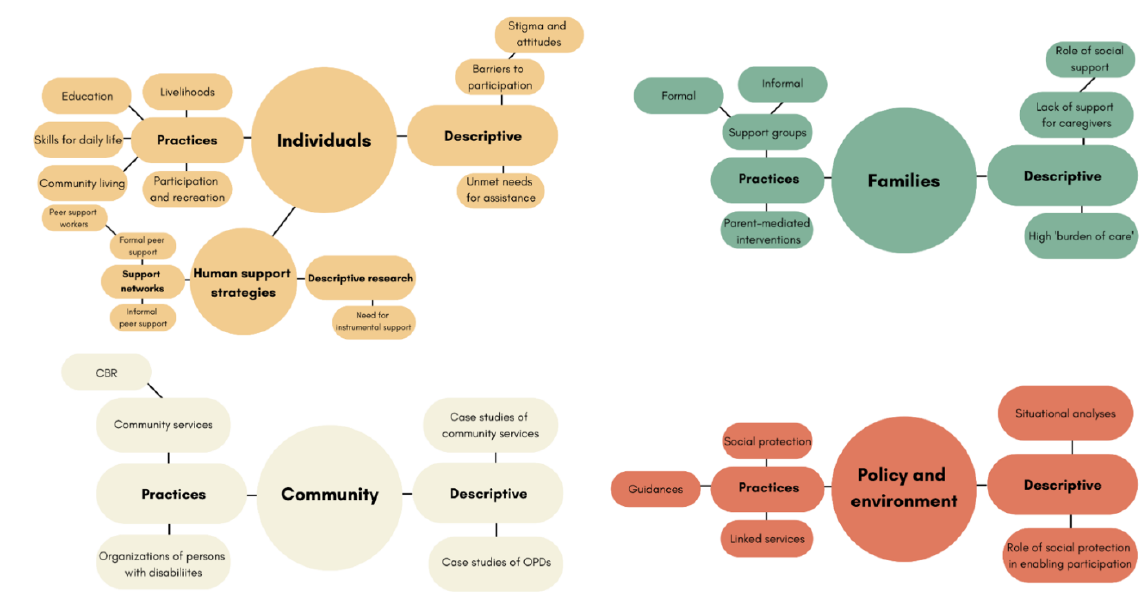
Figure 6. Mapping of key topics in the literature. Table 2. Key topics covered in the literature